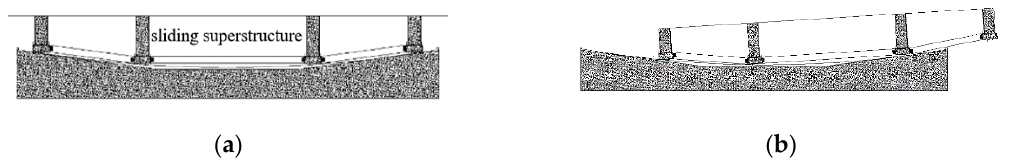
Figure 1. Cross-sectional view of super-large displacement rotation friction pendulum bearing ( a ) without deformation and ( b ) with deformation.